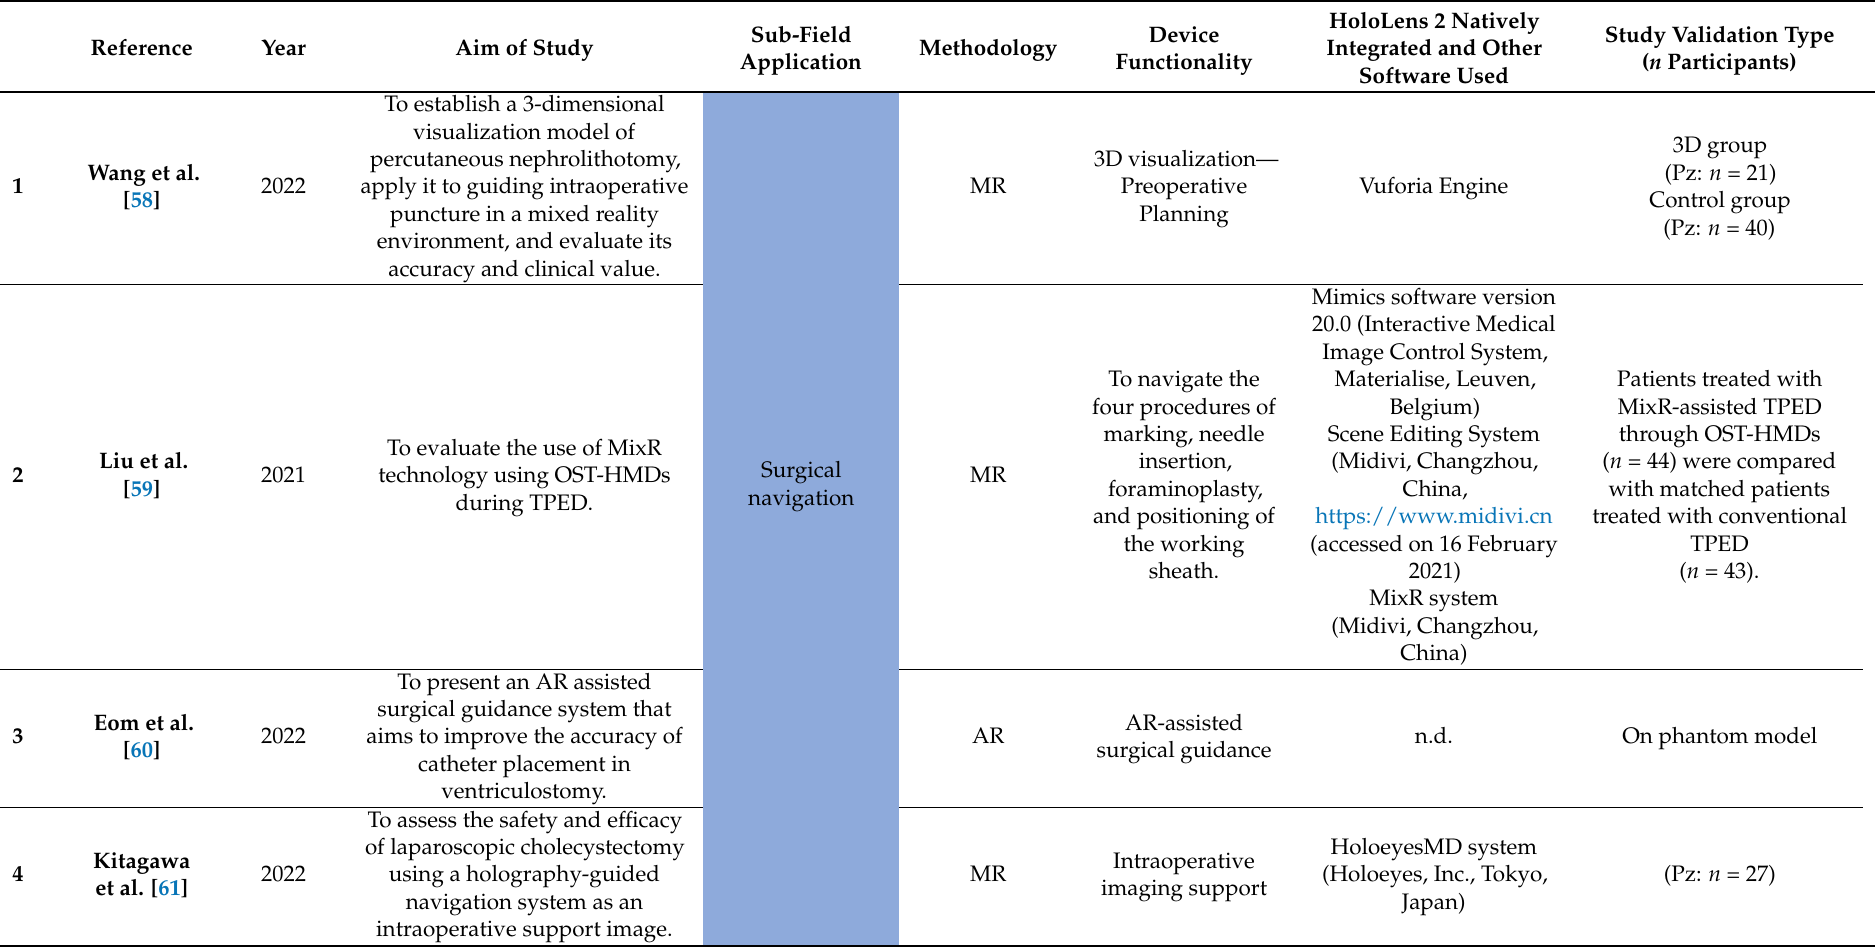
Table 4. Summary of Microsoft HoloLens 2 applications in medical and healthcare